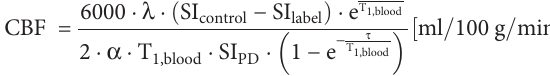
TABLE 1 | Clinical characteristics of all patients.